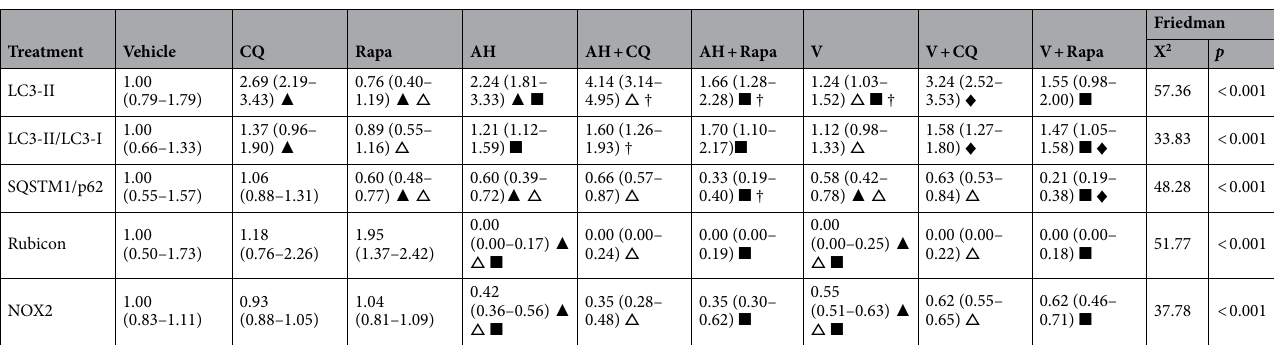
Table 1. Autophagy/LAP related proteins quantification into differentiated PBMCs exposed 4 h to several treatments. Results are expressed as median and quartiles (in brackets) of protein/β-actin level normalized by vehicle median. CQ, Chloroquine. Rapa, Rapamycin. AH, Aluminum oxyhydroxide. V, Whole vaccine (Engerix ® ). ▲ p < 0.05 compared to vehicle treatment. △ p < 0.05 compared to CQ treatment. ■ p <